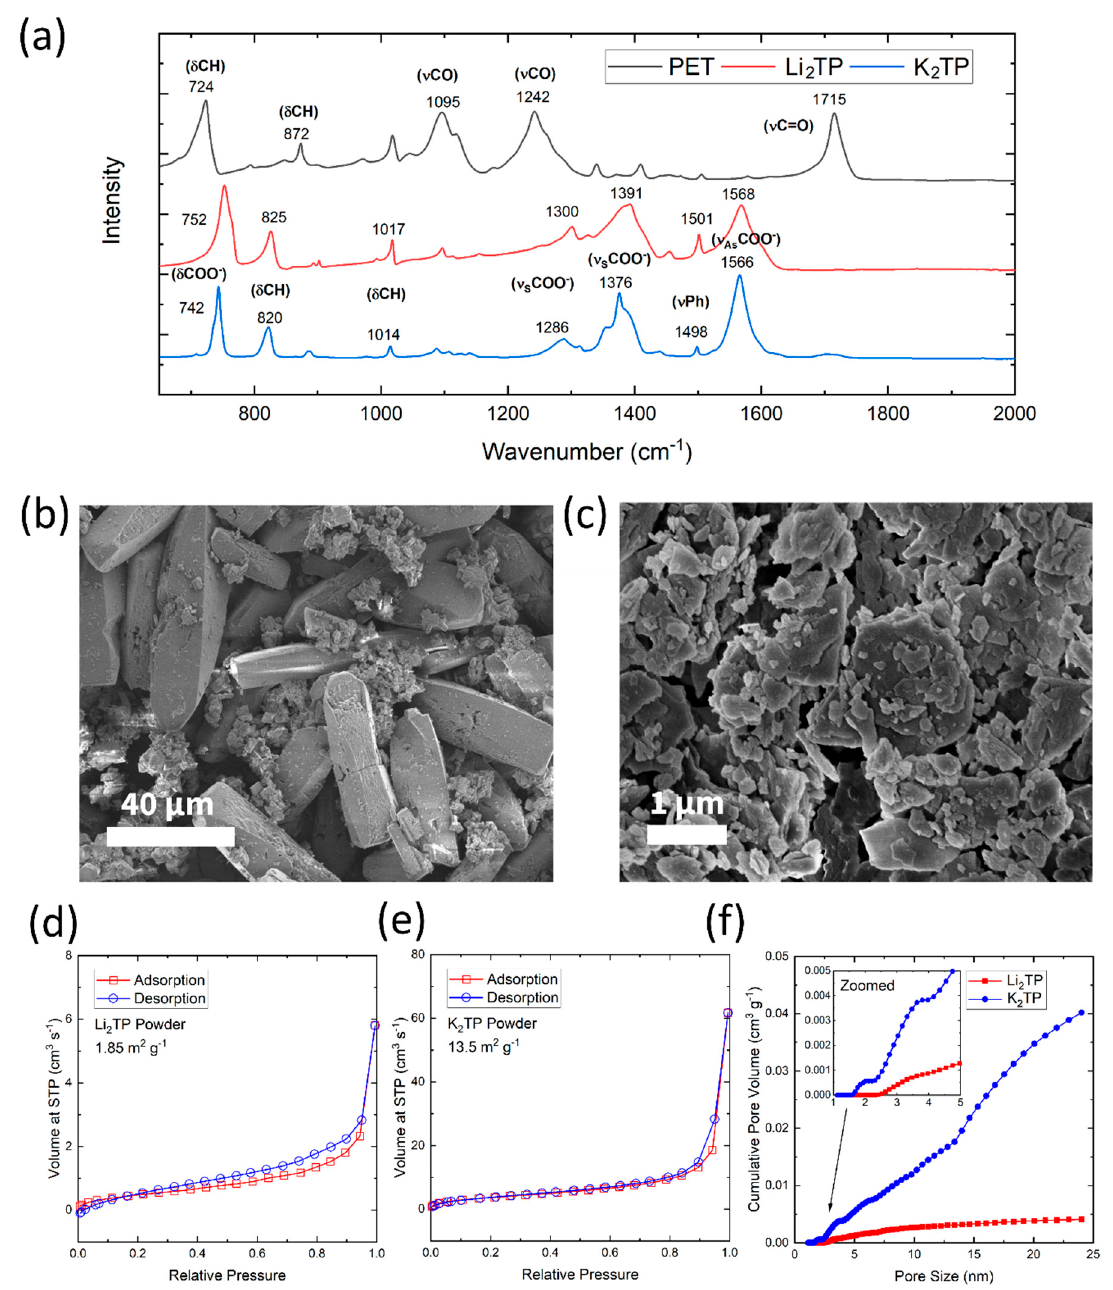
Figure 2. Characterizations of starting materials including ( a ) FTIR spectra of the PET bottle flakes, Li 2 TP, and K 2 TP, as well as SEM images of the synthesized ( b ) Li 2 TP and ( c ) K 2 TP powders. Chara- terization also includes nitrogen adsorption/desorption isotherms with calculated BET surface area for ( d ) Li 2 TP and ( e ) K 2 TP, as well as ( f ) calculated pore size distributions for both TPS.